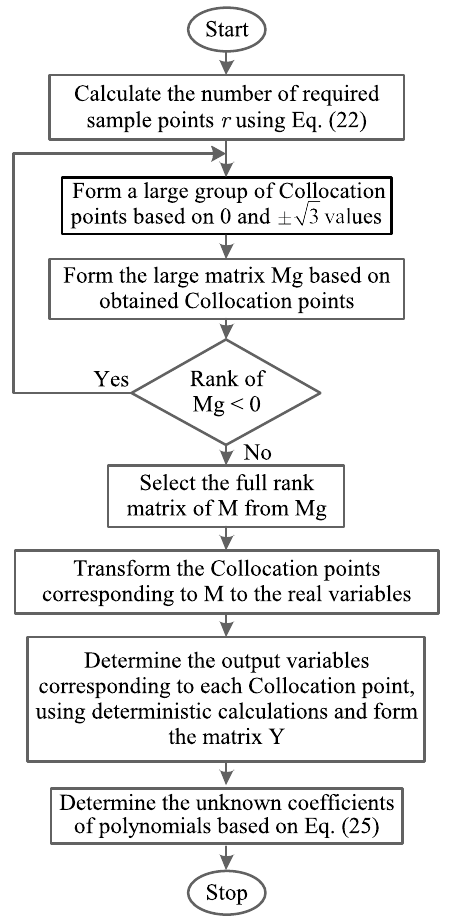
Fig. 1 Flow chart of determining the unknown coefficients of poly- nomials based on the proposed